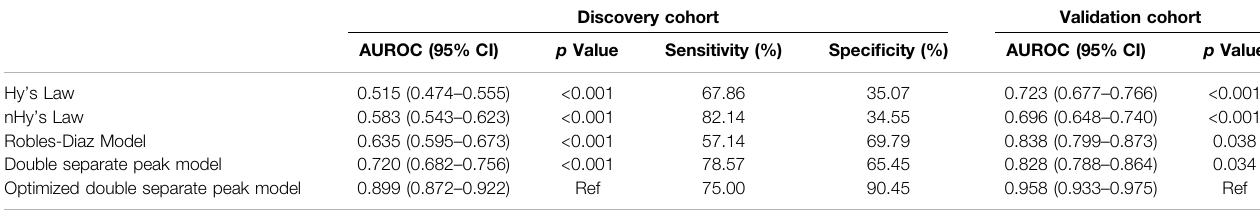
TABLE 3 | Comparison of the double separate peak model with existing prediction models.